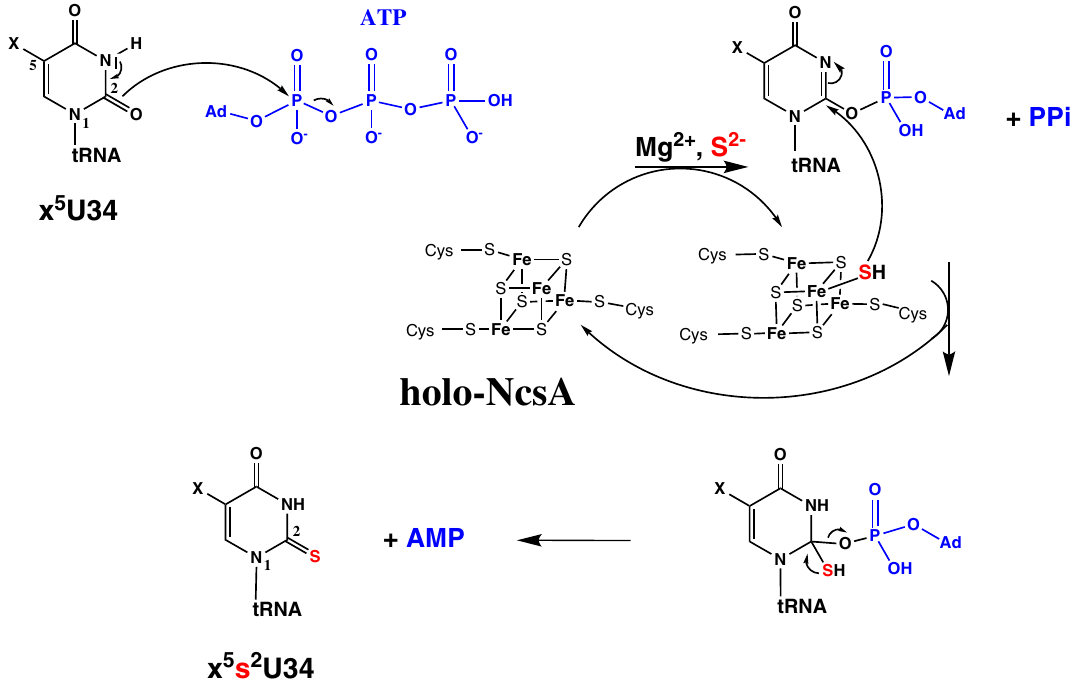
Figure 6. Postulated mechanism of NcsA-catalyzed U34-thiolation based on the mechanism proposed for TtuA 39 . ‘Ad’ stands for